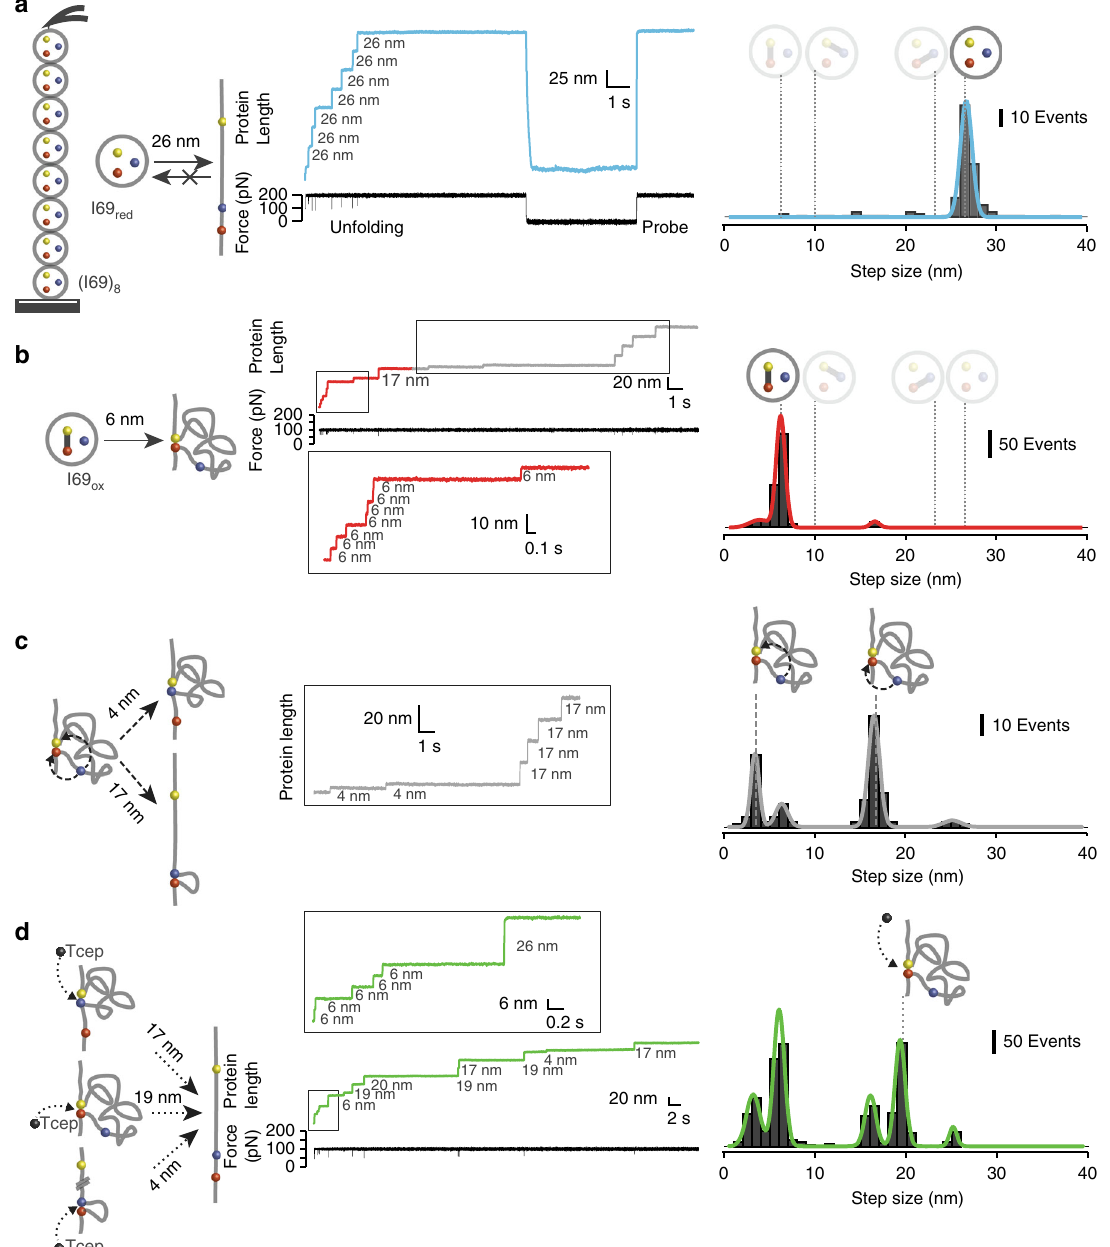
Fig. 3 Mechanical characterization of I69 oxidized identi fi es disul fi de isomerization as a contributor to titin elasticity. Diagrams on the left describe the mechanism of extension of I69 due to unfolding a , b and unfolding-triggered redox reactions c , d . Each pathway is illustrated with a trace and a histogram of step sizes. Theoretical step sizes are indicated by dashed lines (Supplementary Note 2). a The unfolding of (I69 reduced ) 8 pulled at 170 pN results in a uniform step-wise extension of the polyprotein (26 nm steps in the blue trace). Similar to the trace shown in Fig. 2f, the absence of steps in the probe pulse indicates low refolding kinetics of I69 reduced ( Δ t = 5 s). b When (I69 oxidized ) 8 is stretched at 100 pN, a predominant population of 6 nm emerges in the fi rst 3 s, marking the unfolding of I69 domains containing disul fi de CysB – CysG. c After 3 s (gray part of the trace in ( b )), two new populations of 4 and 17 nm steps appear. Mechanical unfolding activates a reaction of disul fi de exchange where the thiol group of CysF can attack either the sulfur of CysB or CysG, giving rise to the 4 and 17 nm step populations. d In the presence of 10 mM Tcep, additional 19 nm steps are detected (Gaussian fi t centered at 19.2 ± 0.3 nm), marking the reduction of disul fi de CysB – CysG by Tcep (black sphere). The reduction of the newly interchanged disul fi de CysB – CysF and CysF – CysG along the trajectory produces steps of 3 and 16 nm